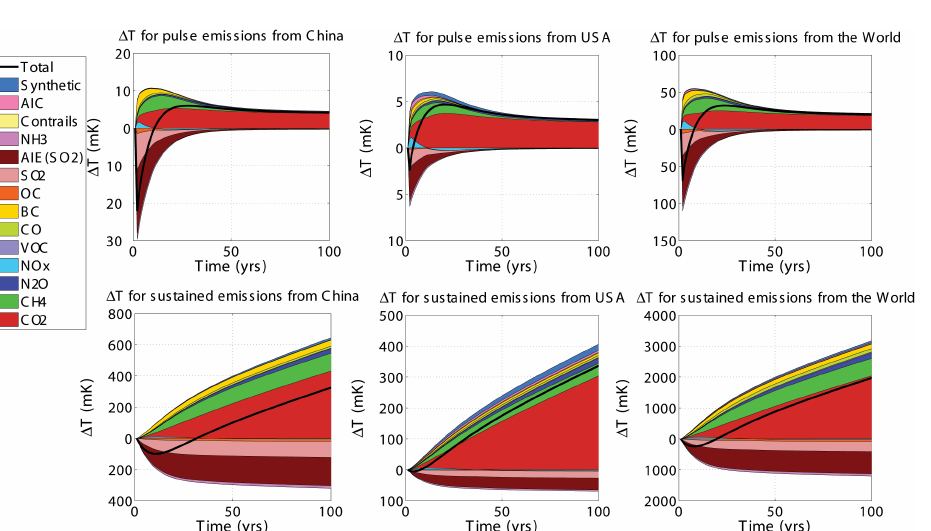
Fig. 10. The estimated temperature perturbation based on AGTP by different species due to EDGAR 2008 emissions. “Synthetic” represents the mainly halogenated hydrocarbons in the Kyoto and Montreal